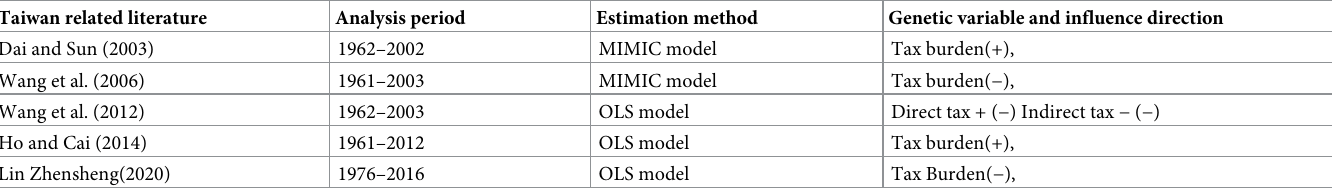
Table 1. Literature review of Taiwan’s underground economy in recent years. Taiwan related